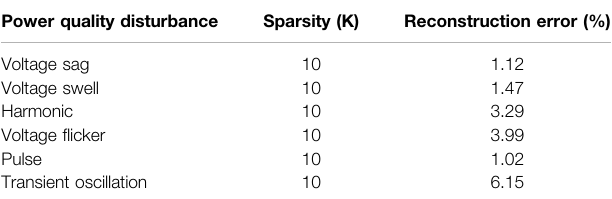
TABLE 1 | Reconstruction error of power quality disturbance